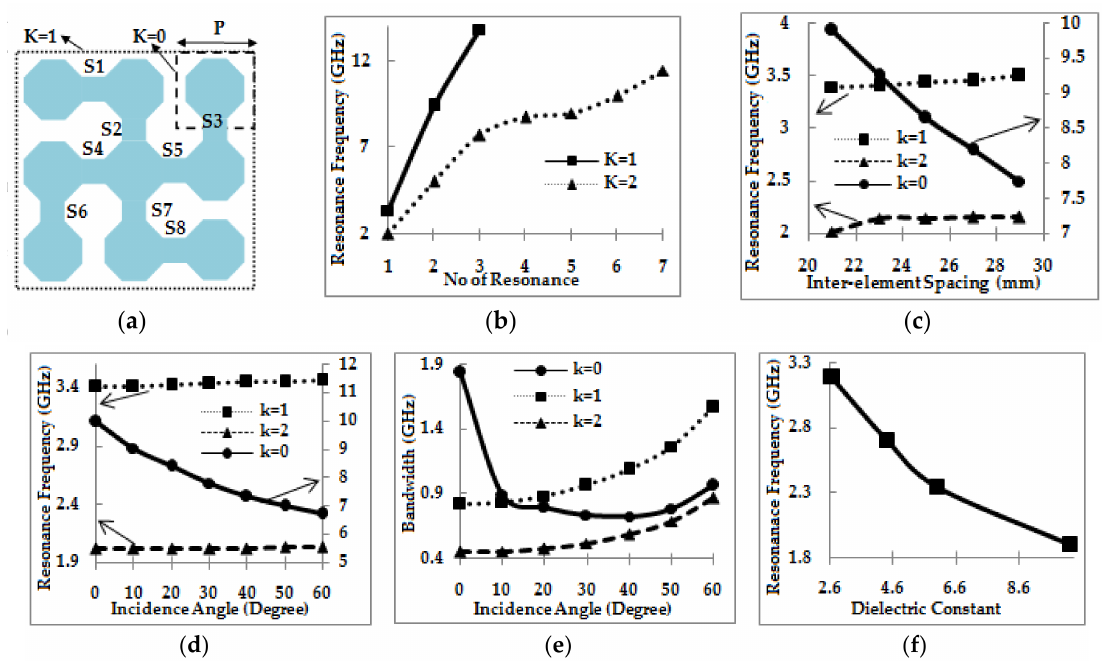
Figure 9. ( a ) FSS pre-fractal based patch element showing reconfiguration possibilities for k = 1 with switch positions ( b ) Number of resonances versus resonant frequency for different fractal levels. ( c ) Effect Inter-element spacing on resonance frequency. Effect of changing the angle of incidence for different fractal levels on ( d ) resonance frequency ( e ) Bandwidth [82]. ( f ) The effect on the resonant frequency by varying the dielectric constant [81].